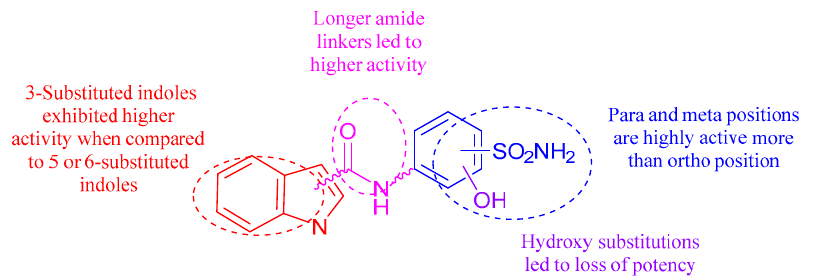
Figure 3. Structure activity relationship (SAR) diagram of the synthesized hybrids 2a ‒ o.